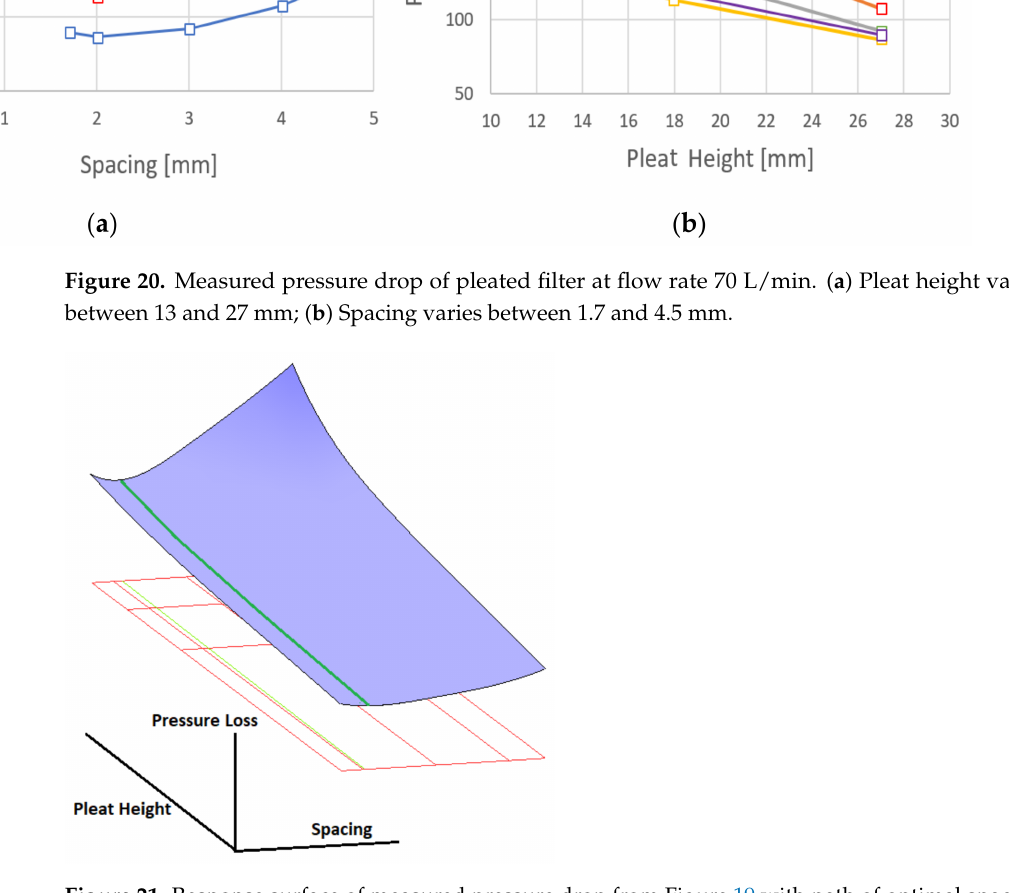
Figure 21. Response surface of measured pressure drop from Figure 19 with path of optimal